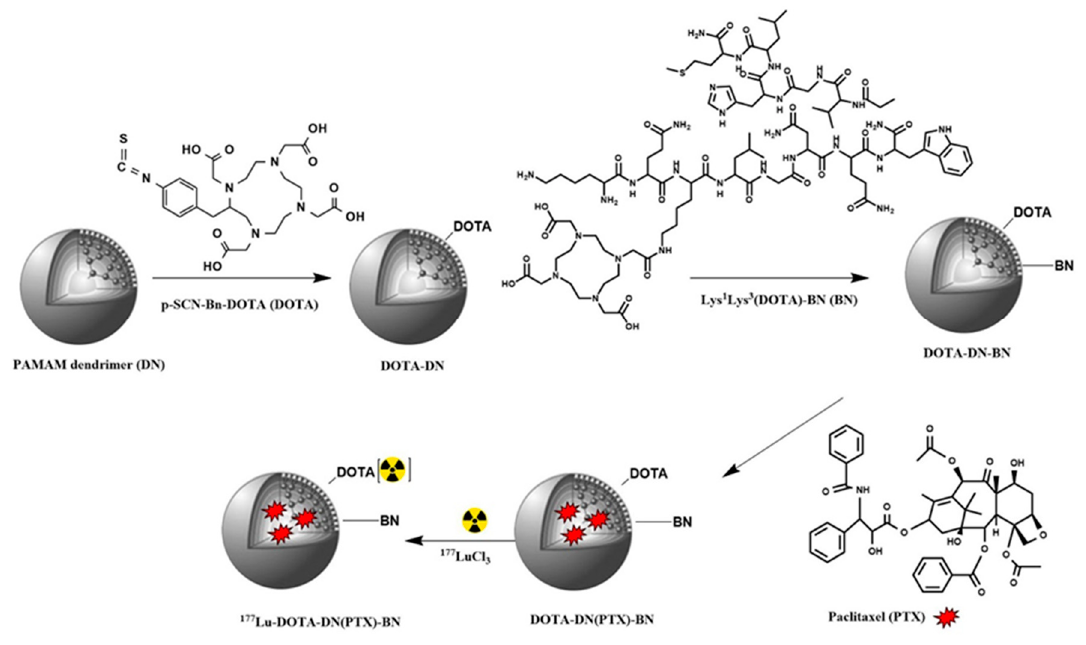
Figure 1. Schematic illustration of 177 Lu-DOTA-DN(PTX)-BN